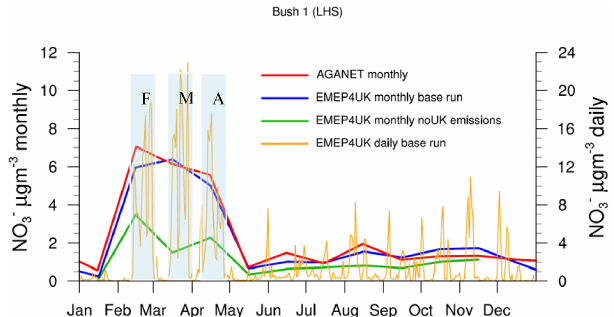
Figure 8. Modelled and observed monthly mean (left axis) and daily mean (right axis) surface concentrations of NO − at the Bush 3 site (Scotland) for the year 2003. The red line shows the measured monthly values from the AGANet network, the blue line shows the modelled monthly means for the base run, the green line shows the modelled monthly means for the experiment with no UK emissions, and the orange line shows the modelled daily means for the base run (all model values are averages of hourly data). The blue shadows highlight the three episodes labelled F, M and